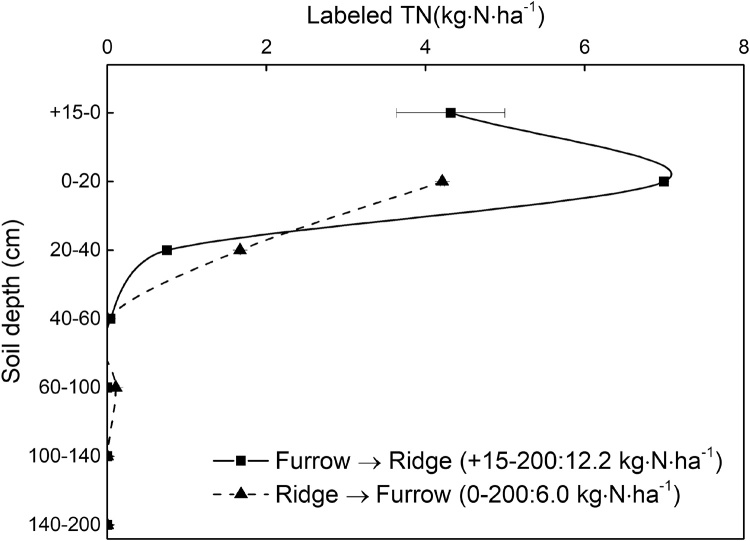
Lateral movement of total residual 15N in the 0–200 cm soil profile for Plastic-Furrow and Plastic-Ridge at the 2015 harvest (Furrow → Ridge: 15N moved from furrows to ridges in Plastic-Furrow; Ridge → Furrow: 15N moved from ridges to furrows in Plastic-Ridge).